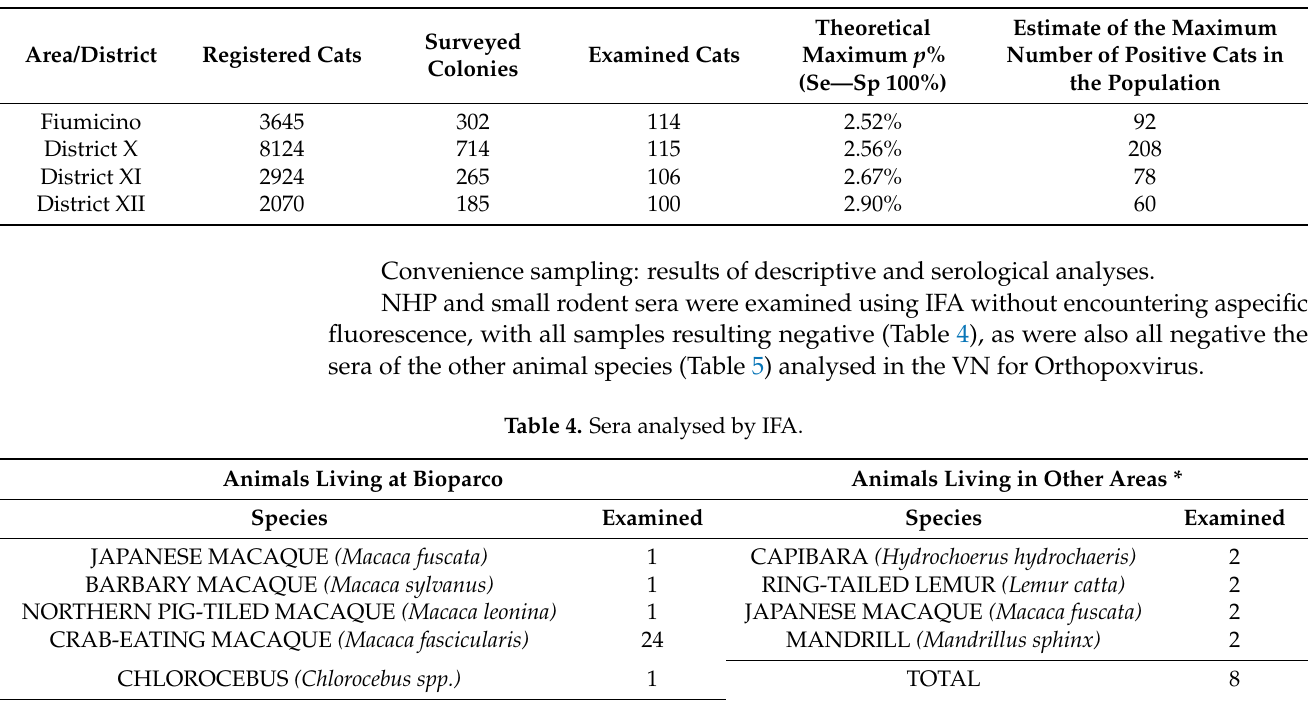
Table 3. Estimation of the theoretical maximum prevalence for each district given the negative result of all samples and considering sensitivity and specificity of the SN equal to 100%.